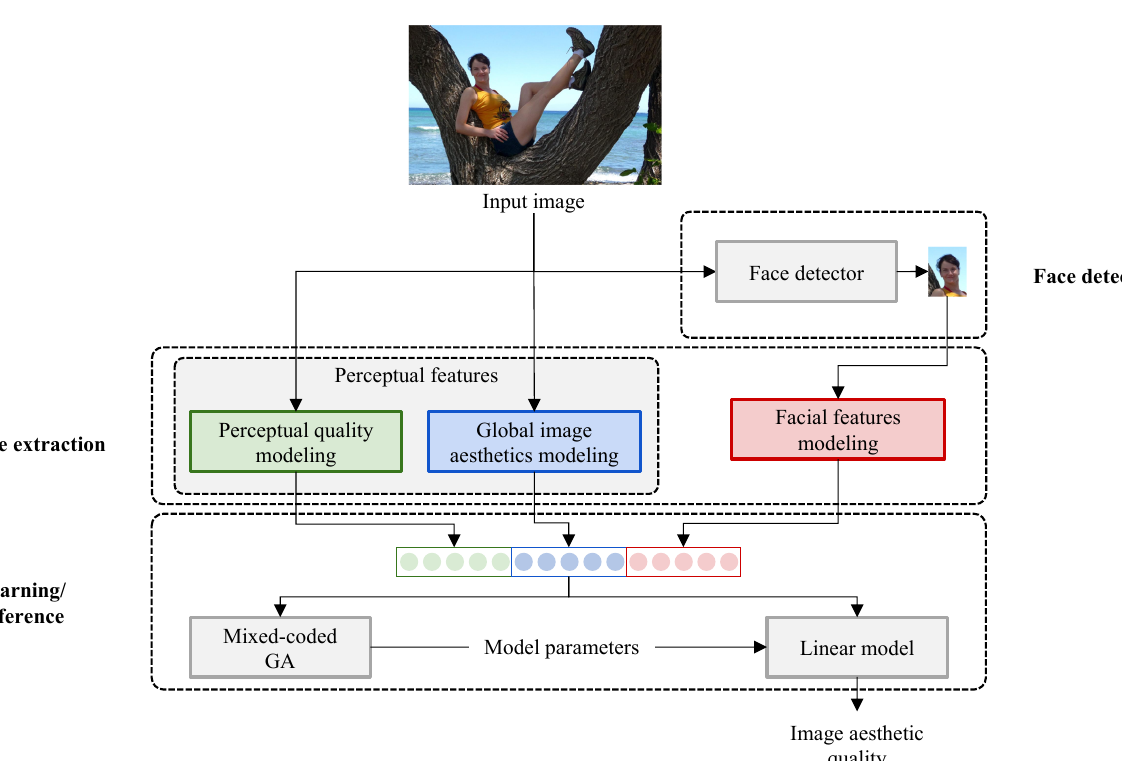
Figure 2. Overview of the proposed method. Given an image containing faces, the largest face is detected and cropped. Perceptual features are extracted from the whole image, while facial features are computed on the crop of the face. A mixed-coded genetic algorithm (GA) is used for estimating the parameters of a linear model, which predicts the image’s aesthetic